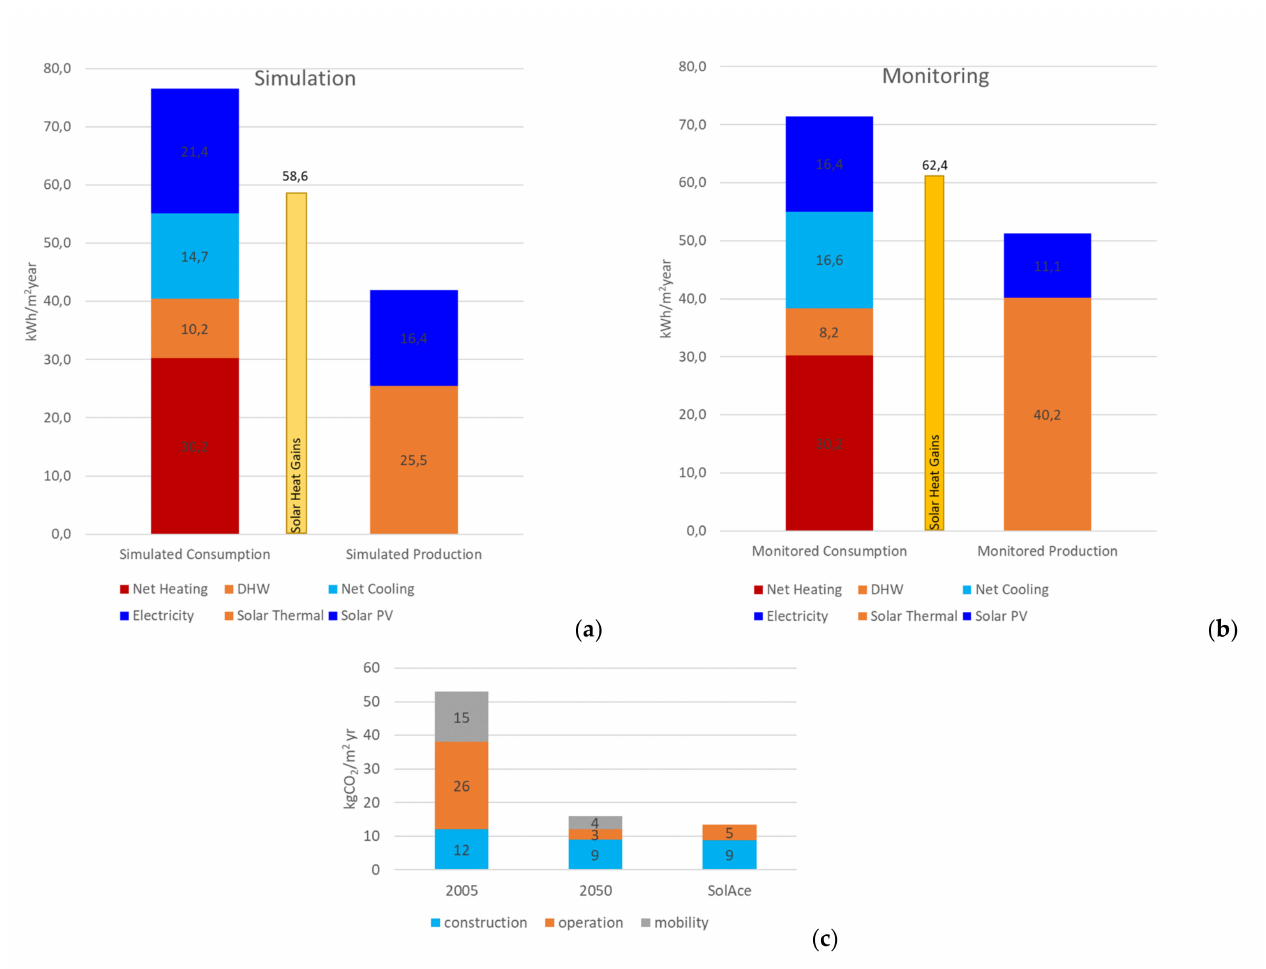
Figure 6. Bar chart of the annual end energy consumption vs the production and simulation scenario ( a ) and data-driven scenario ( b ). ‘Passive solar gains’ are annual and shown only for comparison; CO 2 emissions of the Swiss average buildings in 2005, 2050, and for the SolAce unit ( c ).